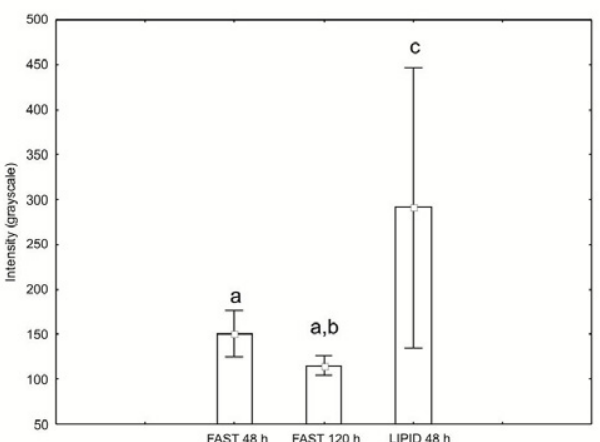
Fig 6. One-way ANOVA analysis of fluorescence intensity (values in grey scale) reflecting acyl-CoA dehydrogenase abundance in the measured areas of a gland cell of postpharyngeal glands of Atta sexdens rubropilosa workers in groups without (FAST 48 and FAST 120 h) and with (LIPID 48 h) lipid supplementation. Bars marked with the same letter show no statistically significant difference (p > 0.05); bars marked with different letters show statistically significant differences (p < 0.05). P values below 5 % were considered